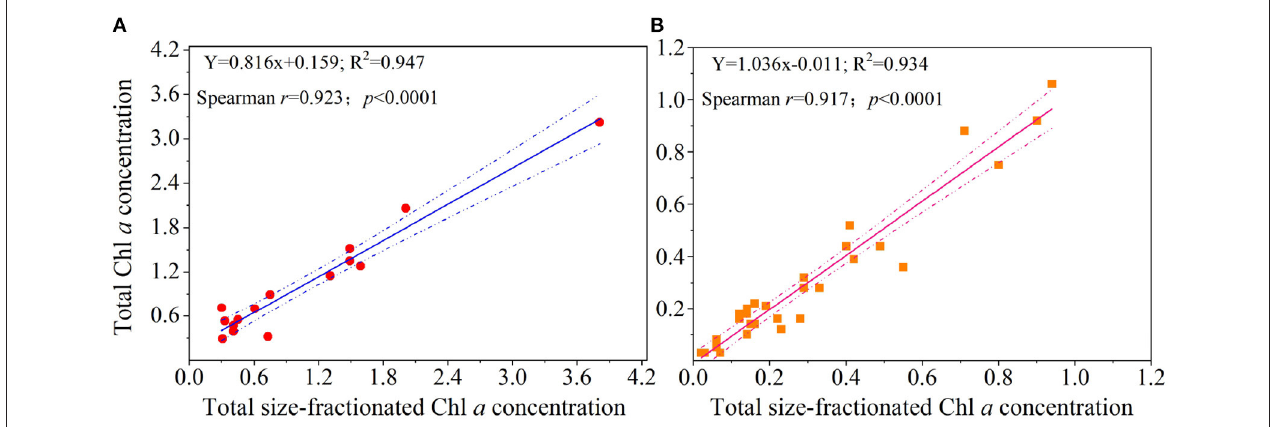
FIGURE 5 | Comparisons of the estimates of total Chl a concentration ( µ g L − 1 ) obtained with GF/F filters (i.e., total Chl a concentration) and size-fractionated PC filters (i.e., total size-fractionated Chl a concentration) in the (A) Yellow Sea and the (B) Western Pacific. Solid lines represent the linear regressions (Spearman’s r , p -values, and regression variance R 2 ), and dashed lines are 95% confidence